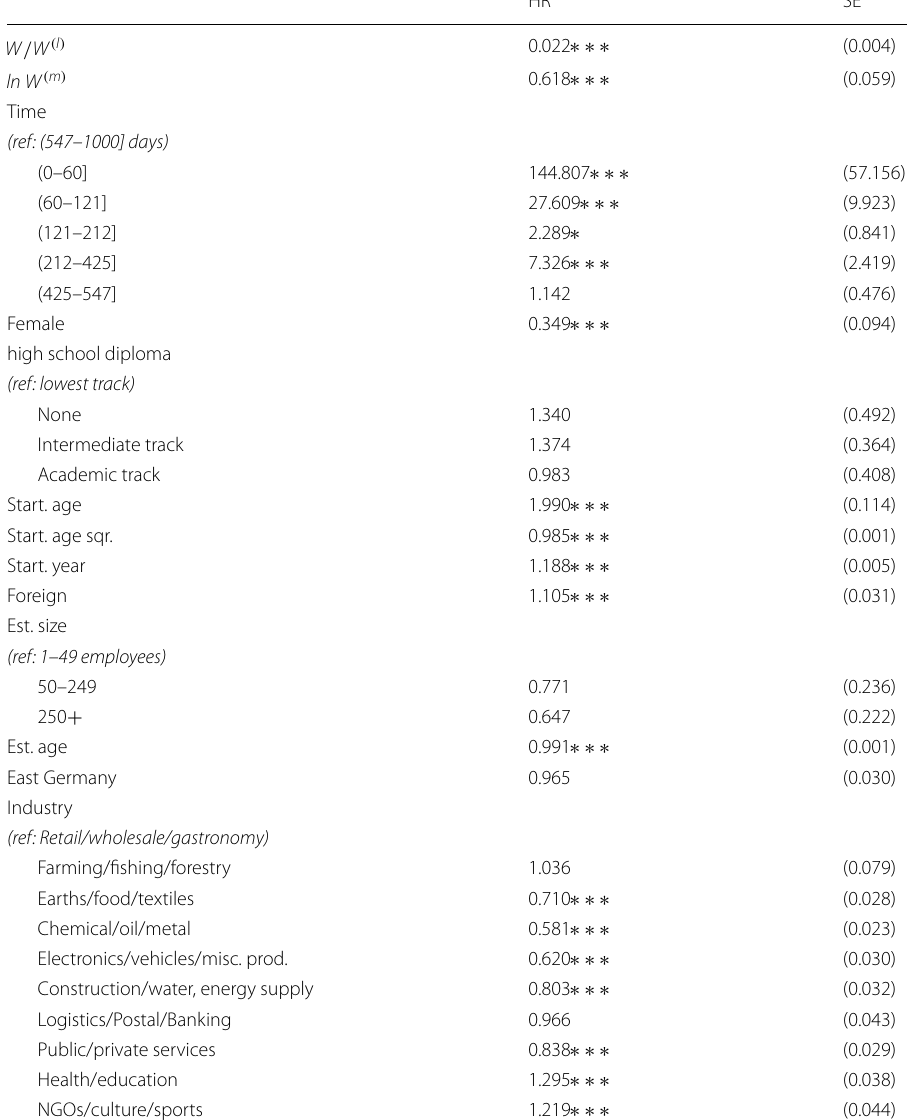
Table 9 Estimated hazard ratios for the piecewise exponential model of the apprenticeship non‑ completion hazard accounting for interaction